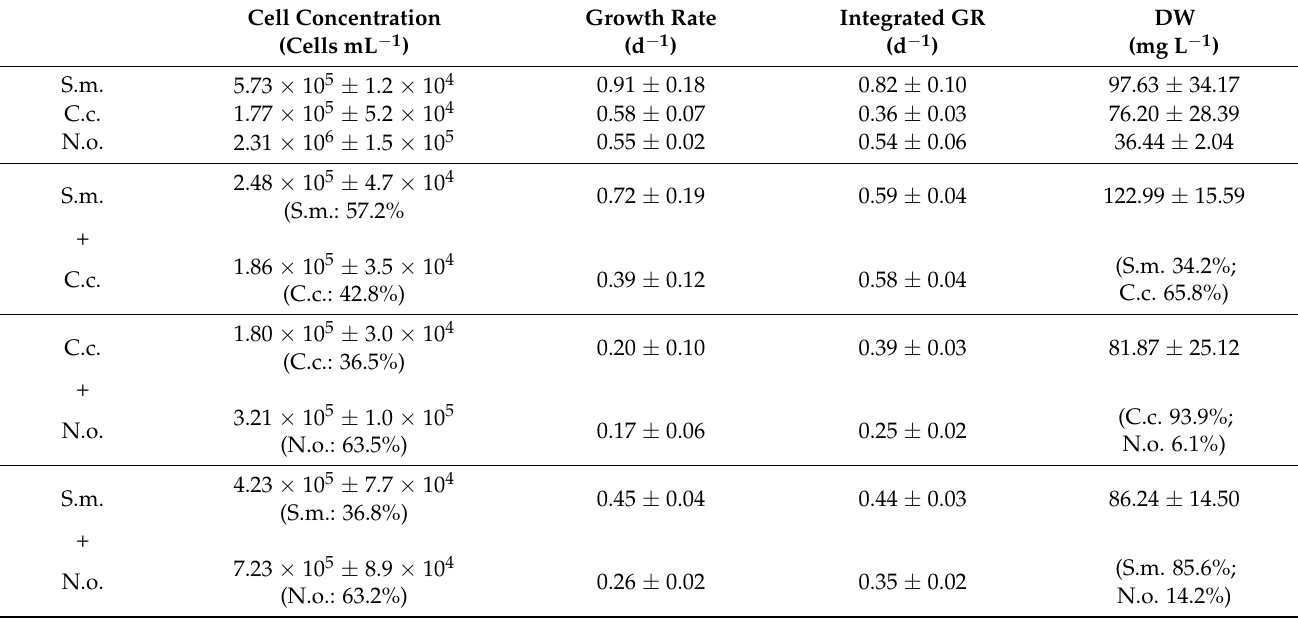
Table 1. Growth and biomass yield of the microalgal